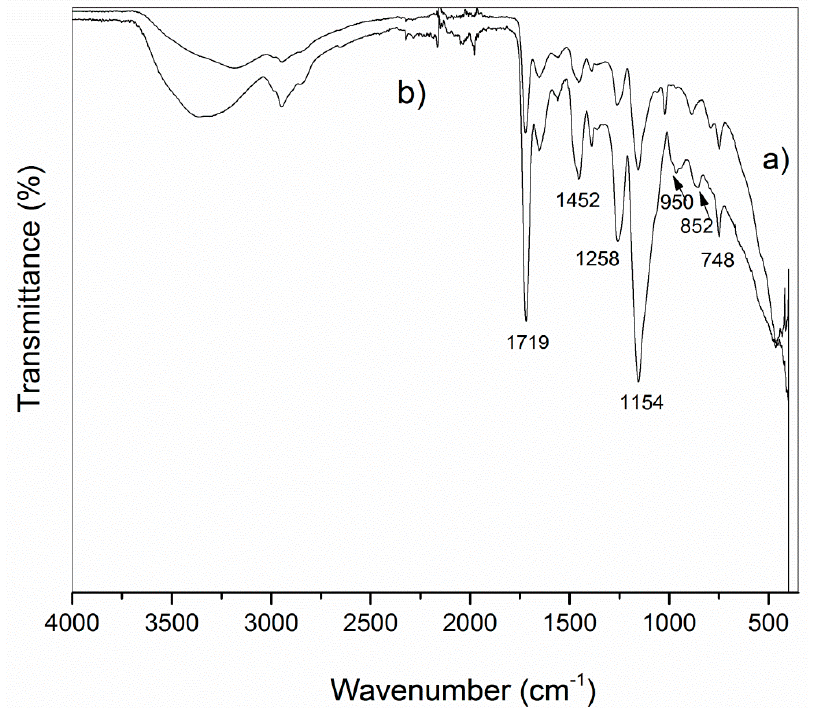
Figure 5. Fourier transform infrared (FTIR) spectrum of adsorbent ( a ) before and ( b ) after Se adsorption.